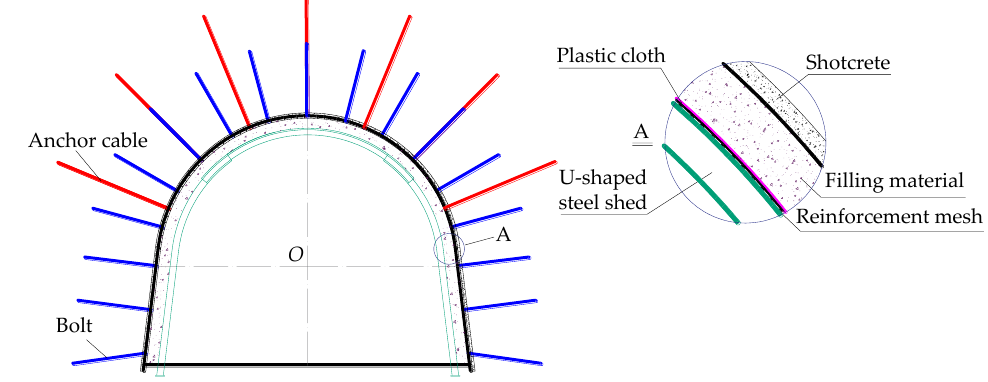
Table 3. Correlation of filling material ’s curing time with the sampl e strength.